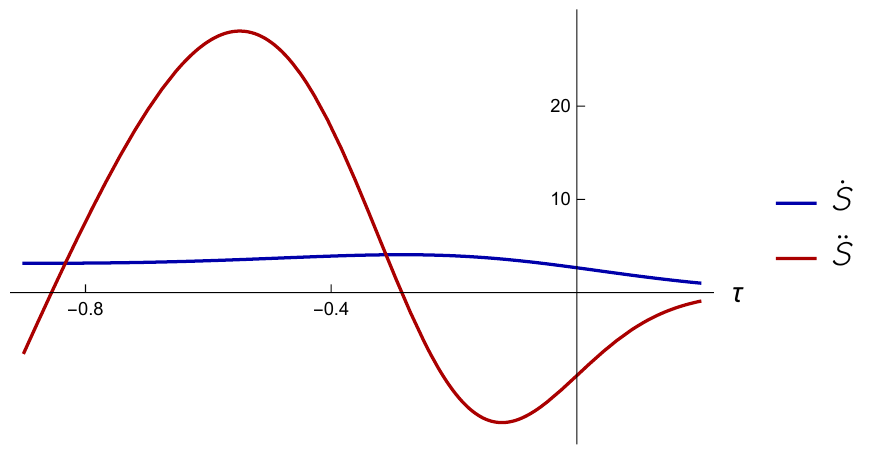
˙ ¨ S ( T ) , S ( T ) as a function of τ , for c A = 1